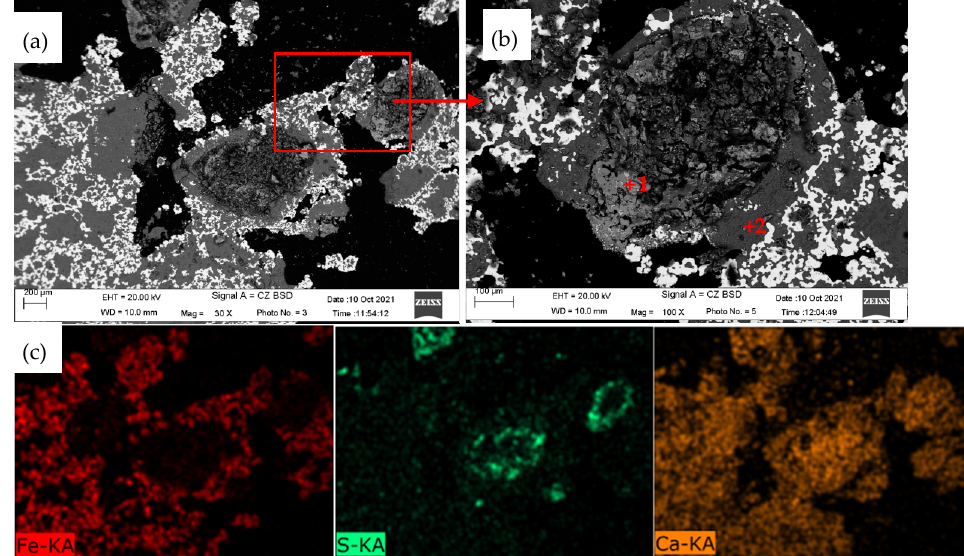
Figure 10 . SEM-EDS images and elemental surface scanning images of roasted products with 15 wt% CaO. ( a ) SEM-EDS images with 15 wt% CaO; ( b ) the structure of magnified inclusion, “+” refer to analyzed point by EDS, numbers refer to composition data in Table 6; ( c ) elemental surface scanning images of ( a ). Table 6. Chemical composition of points indicated in Figure 10 (wt%).